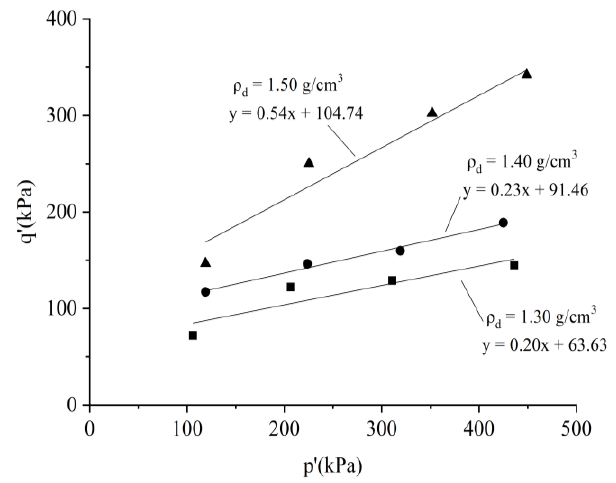
Figure 3. Relationship curve of 𝑝 ′ and 𝑞 ′ .